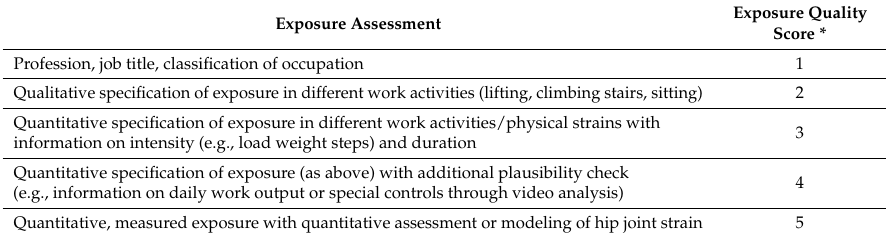
Table 2. Definition of quality for exposure assessment of studies on osteoarthritis of the hip (score 1–5)